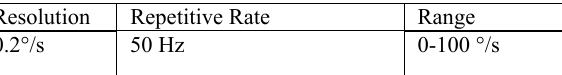
Table 3. Specification of the yaw rate